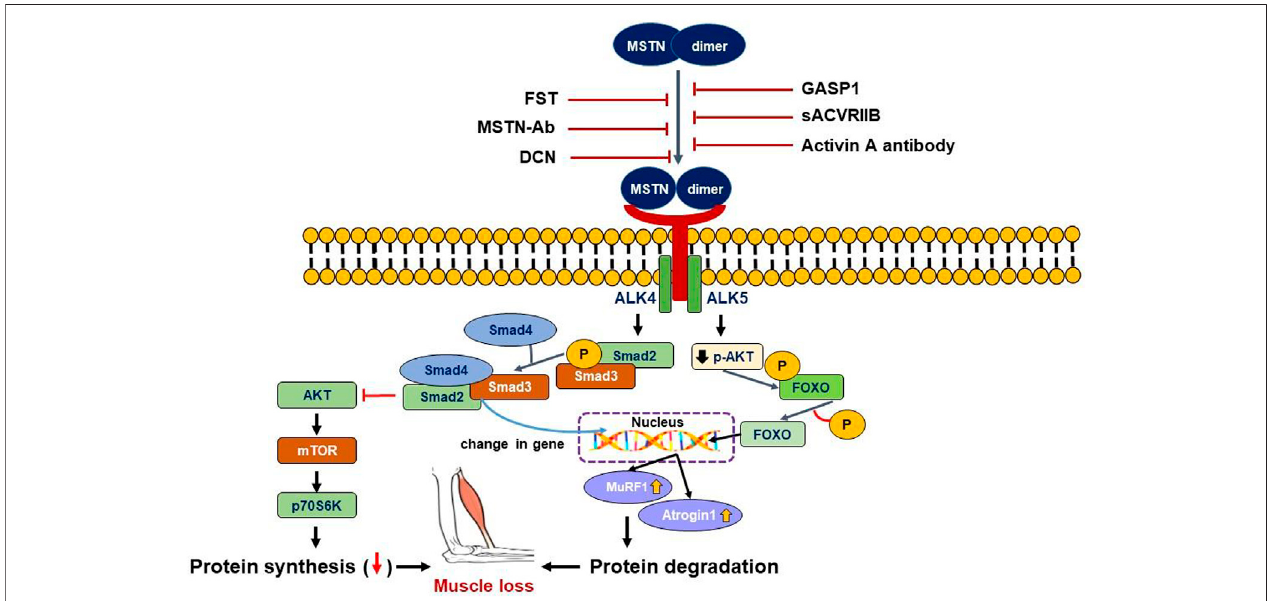
FIGURE1| Smadandnon-SmadmediatedsignalingpathwayofMSTN.MSTNbindstotheACVRIIBandALK4/5complexresultinginsuccessivephosphorylation of Smad2/3, leading to its binding with Smad4 and translocation of the complex to the nucleus. Non-Smad signaling, on the other hand, tends to suppress the AKT intracellular signaling pathways. Both Smad and non-Smad mediated signaling cause gene transcriptional alterations in the nucleus, as well as activation of muscle atrophymarkergenes(MuRF1andAtrogin1),resultinginmuscleloss.Extracellularly,MSTNpathwayinhibitorscanbindMSTNdirectlyorbinditsreceptorcomplex to prevent MSTN from interacting with its receptor complex and triggering downstream